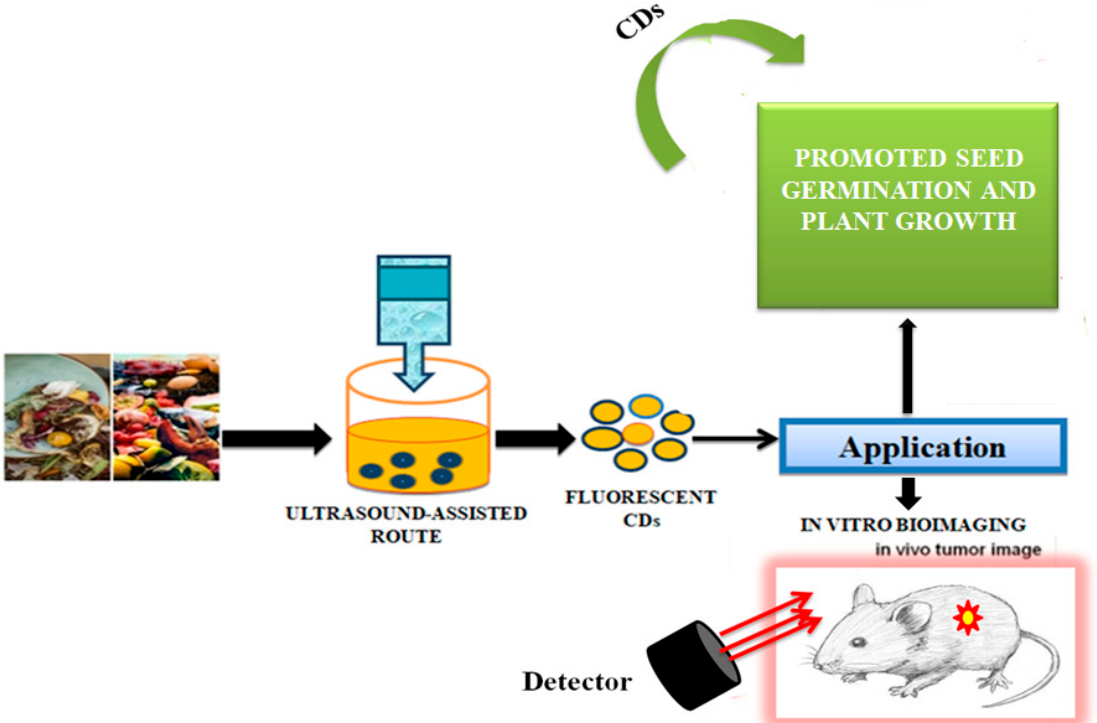
Figure 5. Synthesis of carbon dots from the waste food. The CDs were successfully used for in vivo tumour imaging, as described in [104].